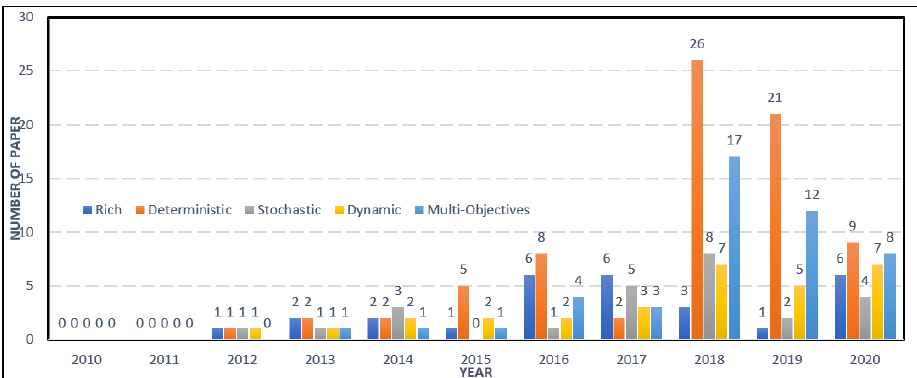
Figure 37. Disaster Types Addressed by Literature According to Year of Publication.